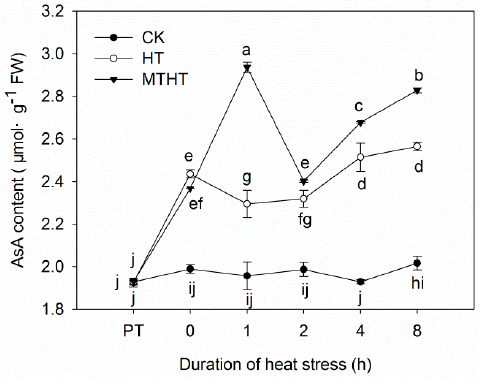
Figure 3. Ascorbic acid (AsA) content in kiwi leaves under heat stress. Lowercase letters indicate significant differences ( p < 0.05).